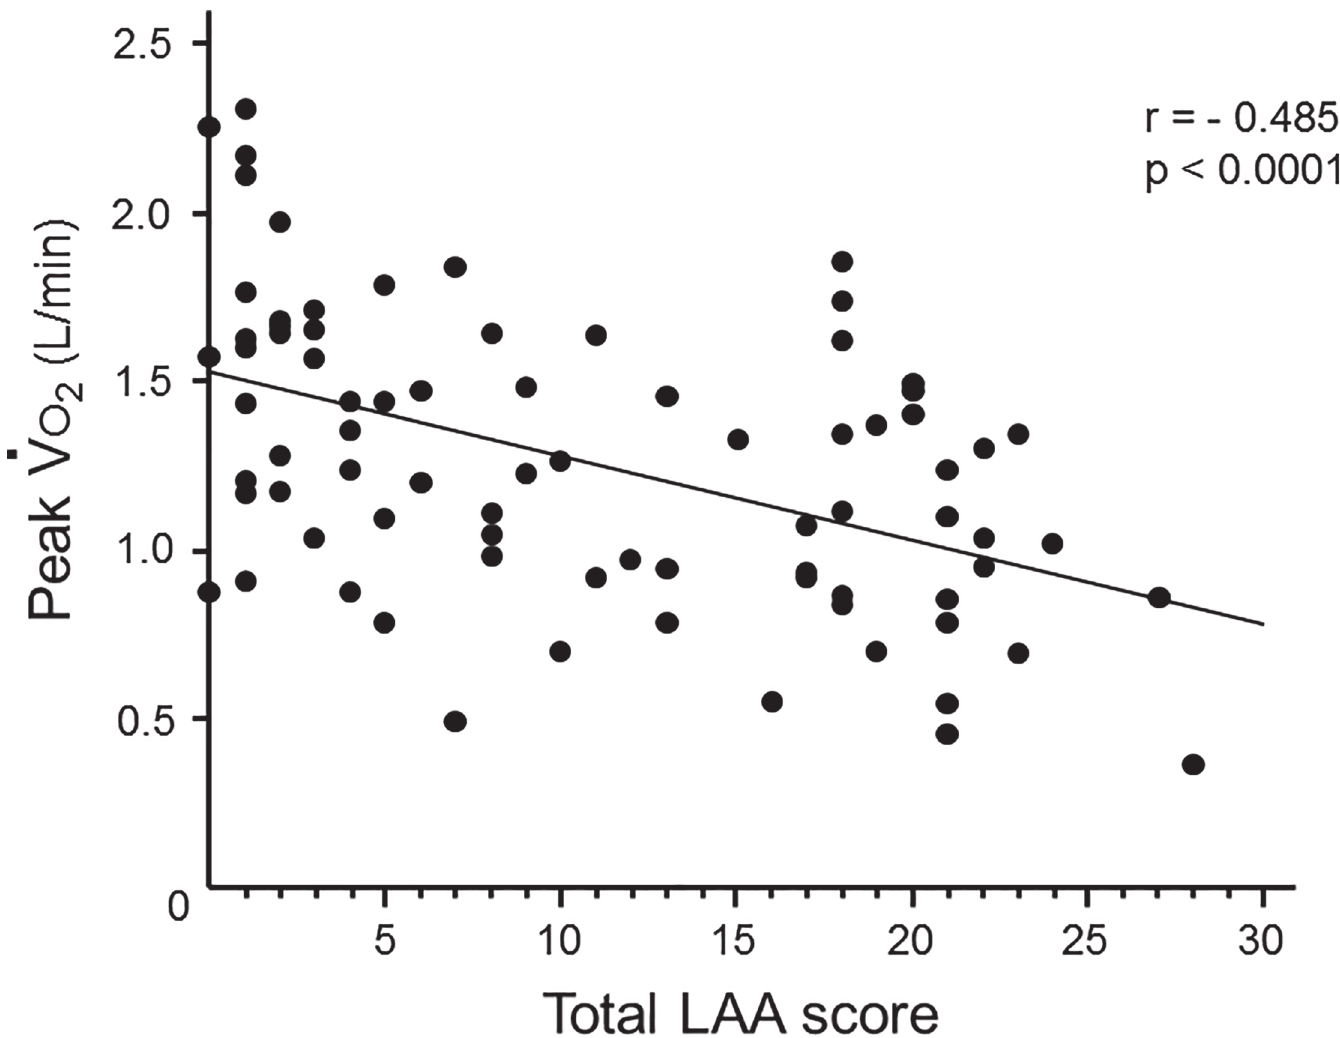
Fig 1. Association between aerobic capacity and emphysematous changes. The aerobic capacity at peak exercise (peak _ V O 2 ) was inversely correlated with total LAA scores (p < 0.0001, r = -0.485).